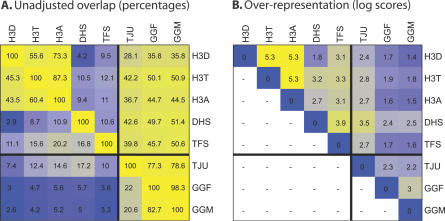
Co-Localization between the Five Components of the Open Chromatin Score and the Three CpG Island Maps(A) shows the relative frequency of overlap between epigenetically modified sites and CpG islands (percentage values).(B) shows the degree of over-representation relative to a simulated case where sites are uniformly distributed over the chromosomes (base-2 log scores). Yellow boxes correspond to frequent overlap, blue boxes to rare overlap. H3D, histone H3K4 dimethylation; H3T, histone H3K4 trimethylation; H3A, histone H3K9/14 acetylation; DHS, DNase I hypersensitive sites; TFS, SP1 transcription factor binding, plus the CpG island abbreviations used throughout this study (TJU, GGF, and GGM). (B) is symmetrical as the result of averaging, therefore only the upper right triangular matrix is reported. (A) is not symmetrical, as is obvious from an example: 51.4% of all 578 known DNase I hypersensitive sites on Chromosomes 21 and 22 overlap with a GGM CpG island, while only 5.0% of all 5,913 GGM CpG islands overlap with an experimentally determined DNase I hypersensitive site.